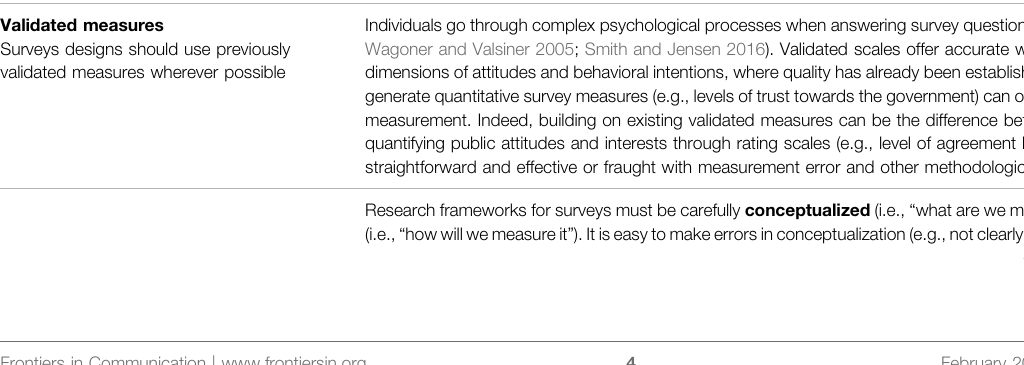
TABLE 2 | Key methodological considerations for COVID-19 survey